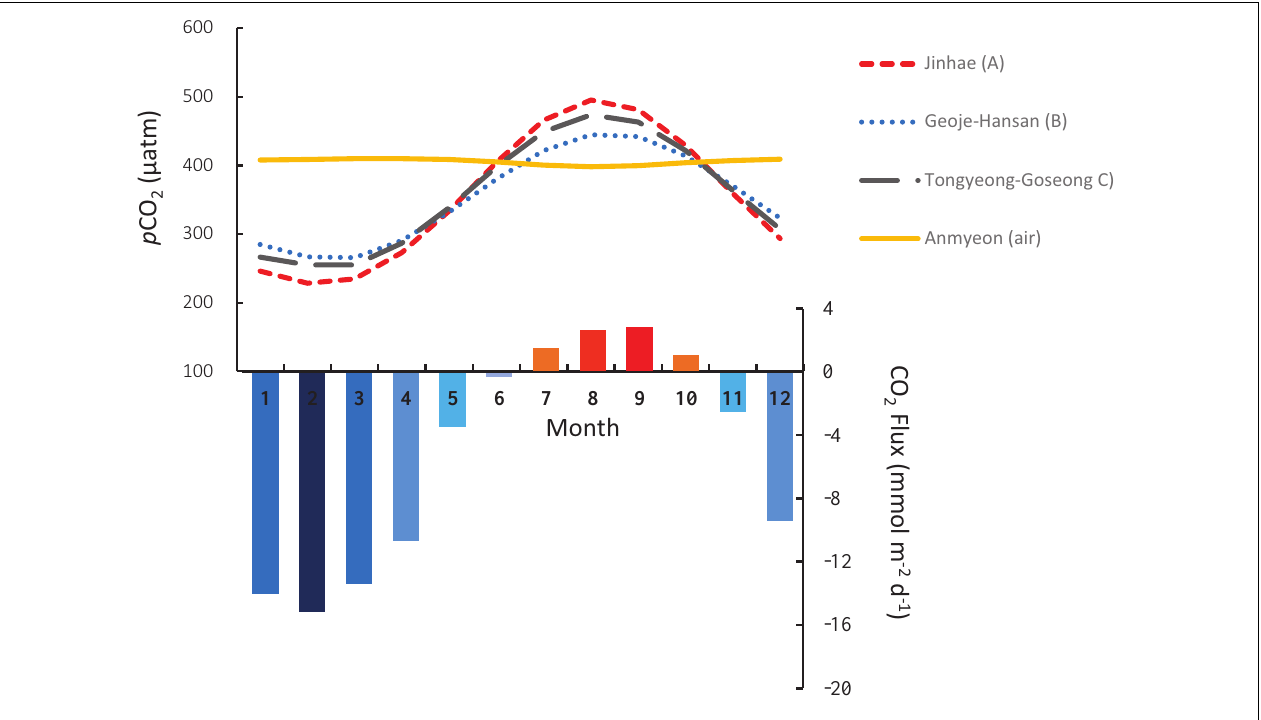
FIGURE 10 | Monthly variation of p CO 2 in seawater for the three bay areas (dotted and dashed lines) and in the atmosphere at Anmyeon-do (solid line), and CO 2 flux of the study area (bars). Surface seawater p CO 2 was calculated from the observed p CO 2 -temperature relationship and monthly temperature variation at each area, derived from expectations using 5 years of even month